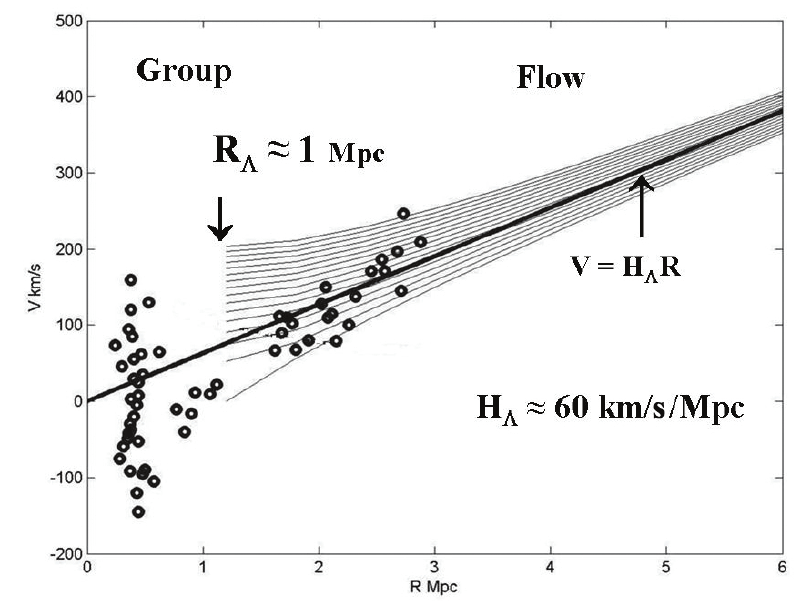
Fig. 1. Velocity-distance diagram for the expansion (cid:29)ow around the Local Group. The zero-gravity distance R Λ is about 1 Mpc. The gravitationally bound group is located at the distances R < R Λ where gravity dominates; the (cid:29)ow is at R > R Λ where antigravity dominates. The phase trajectories of the (cid:29)ow are given by Eq. 8; they converge with distance to phase attractor shown as the bold line V = H Λ R